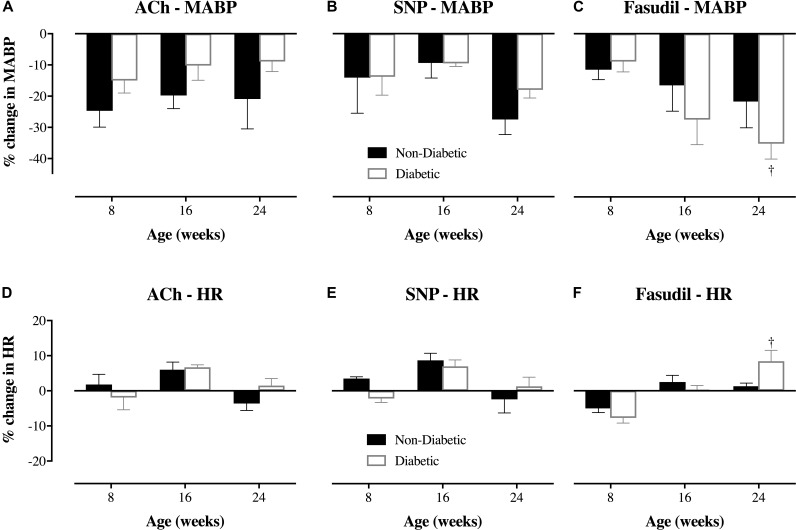
Magnitude of change (%) in mean arterial blood pressure (MABP) and heart rate (HR) of db/db diabetic and non-diabetic mice (mean ± SEM) at 8 weeks old (n = 8 and n = 7, respectively), 16 weeks old (n = 10 and n = 9, respectively), and 24 weeks old (n = 8 and n = 7, respectively) in response to (A,D)
acetylcholine (ACh – 10.0 μg/kg/min for 5 min), (B,E)
sodium nitroprusside (SNP – 10.0 μg/kg/min for 5 min), and (C,F)
fasudil (20 mg/kg, i.v.). †Significantly different from the response of 8-week-old diabetic mice (P < 0.05).